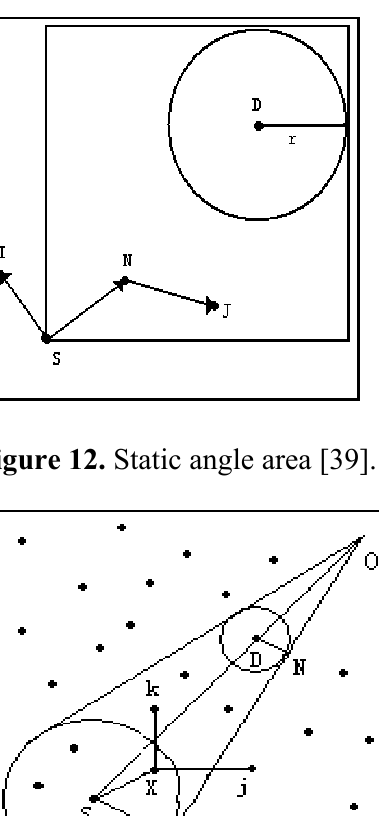
Figure 11. Distance limited flooding area [39].